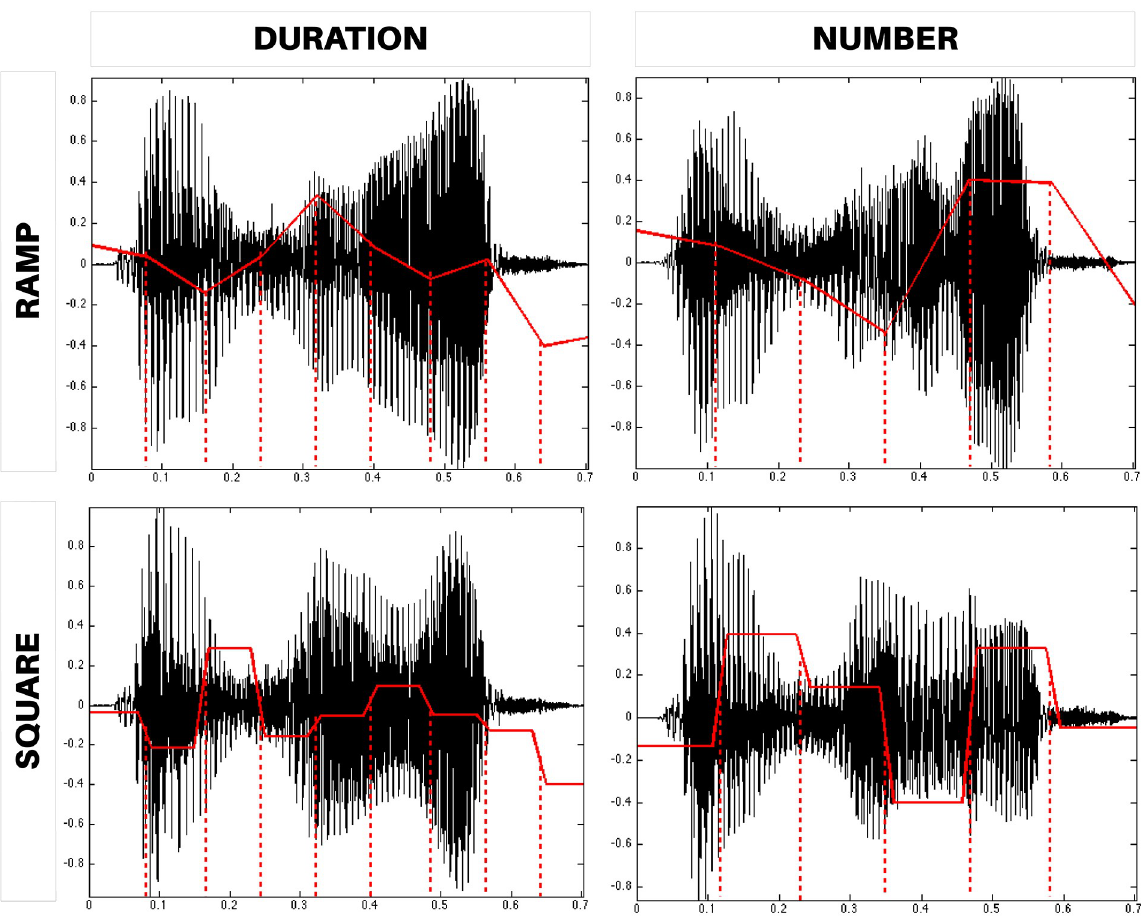
Fig 2. CLEESE operates by generating a set of random breakpoint functions (BPFs) which control the dynamically-changing parameters of the sound transformations. In ramp BPFs (top), transformation parameters are interpolated linearly between breakpoints. In square BPFs, they are constant in each segment. BPFs can be specified either in terms of fixed duration (left: 80ms segments) or fixed number of segments (right: 6 segments).